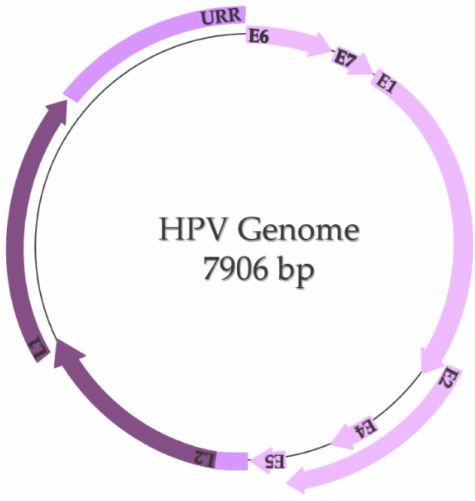
Figure 3. HPV genome (adapted after Bowden and Kyrgiou, 2020